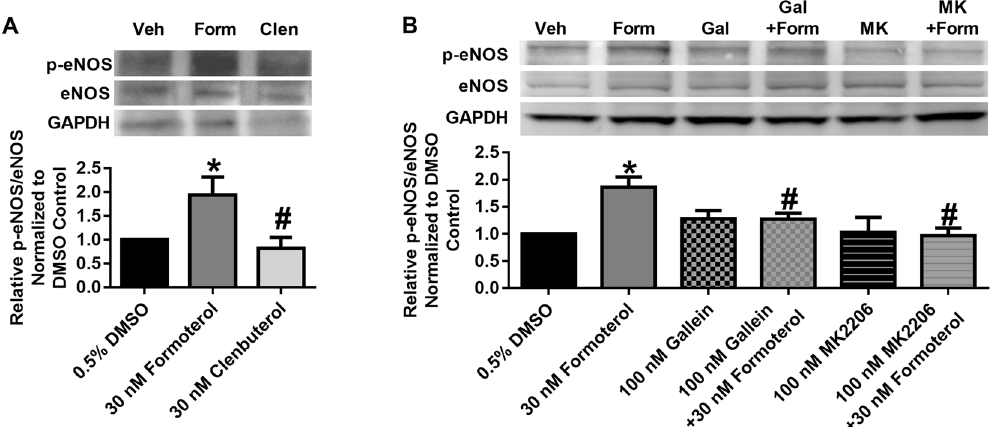
Figure 3. Formoterol (Form), but not clenbuterol (Clen), activates eNOS in a G βγ - and Akt-dependent manner in RPTC. ( A ) p-eNOS was measured following 1 h of formoterol or clenbuterol. N = 5–6. ( B ) Phosphorylation of eNOS was measured following 30 min of treatment with formoterol in the presence or absence of the G βγ inhibitor gallein (Gal) or the Akt inhibitor MK2206 (MK). N = 7–10. Images are cropped to show only relevant bands. Full sized images are available in Supplemental Figure 3. Mean + SEM. * p < 0.05 vs. DMSO, # p < 0.05 vs formoterol, one-way ANOVA with Sidak’s multiple comparison